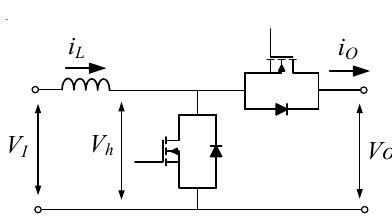
/ DC converter electric circuit. Figure 11. DC/DC converter electric circuit. Figure 11. DC